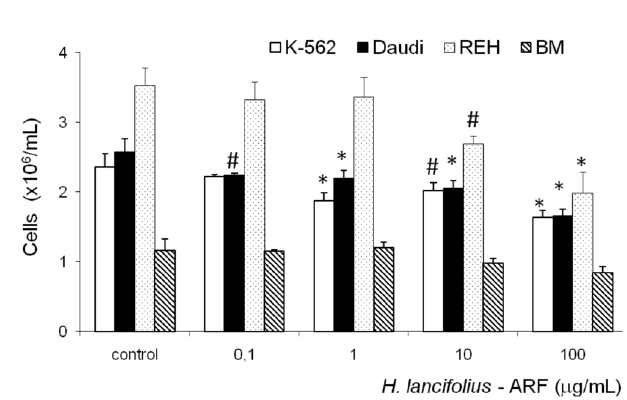
FIGURE 1 - Dose-dependent inhibition of H. lancifolius alkaloid-rich fraction in growth of leukemic and normal cells. Exponentially growing cells were treated with the indicated doses of ARF for 48 h, at 37 °C. Each bar represents the number of recovered cells±EPM from at least 3 experiments, each performed in triplicate. [#] p <0.05; [*] p <0.001.